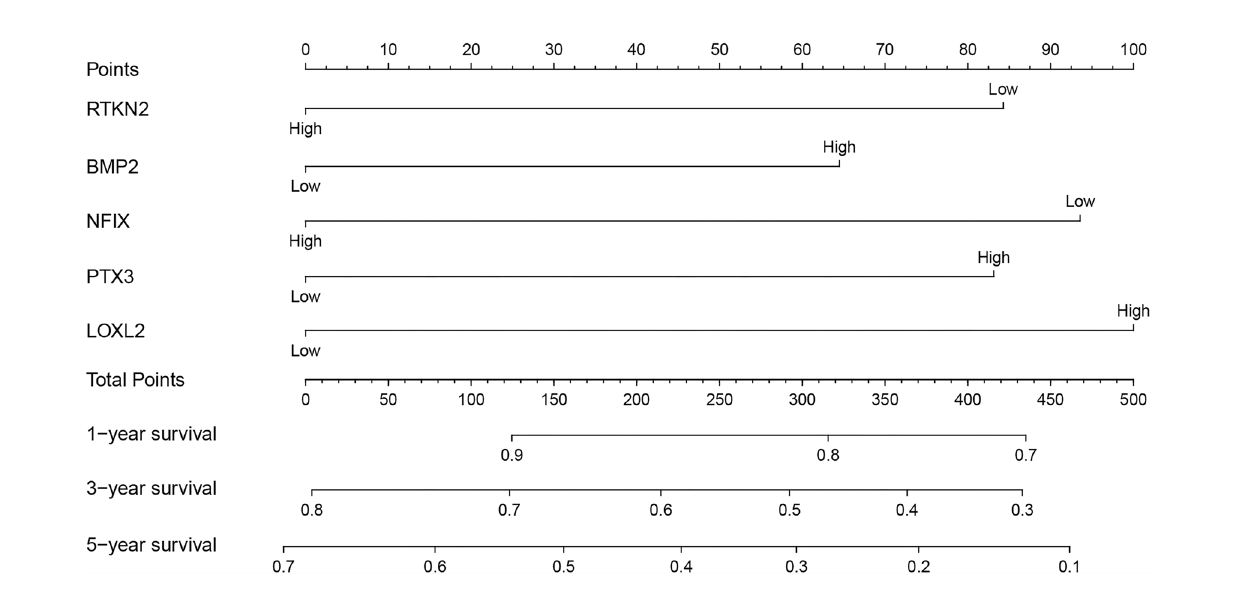
FIGURE 9 | Alignment to construct prognostic related